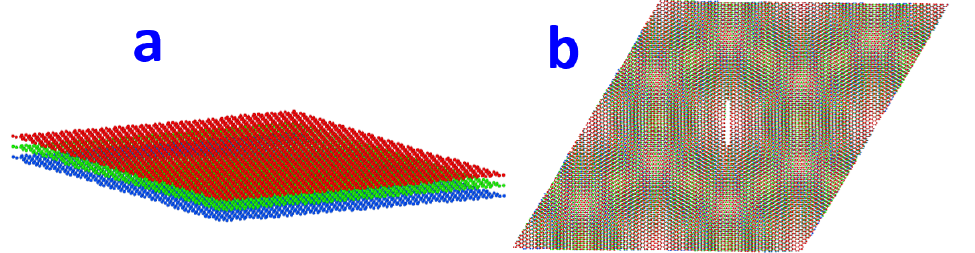
Figure 2. ( a ) Pristine tTLG structure; and ( b ) cracked tTLG structure (top